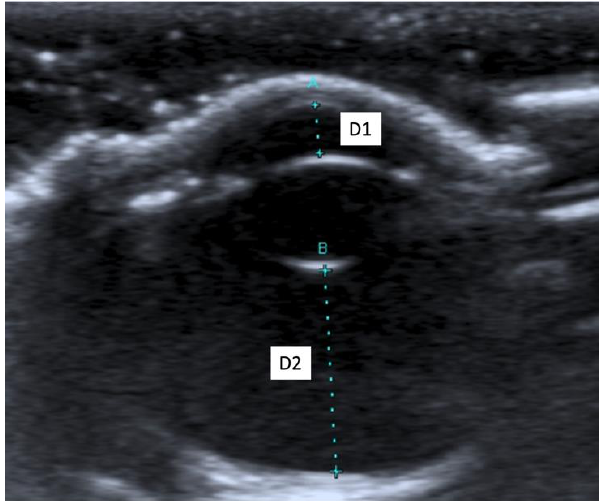
Figure 1. ( A ) The distance between cornea and anterior lens capsule (D1); ( B ) the distance between posterior lens capsule and optic papilla (D2).